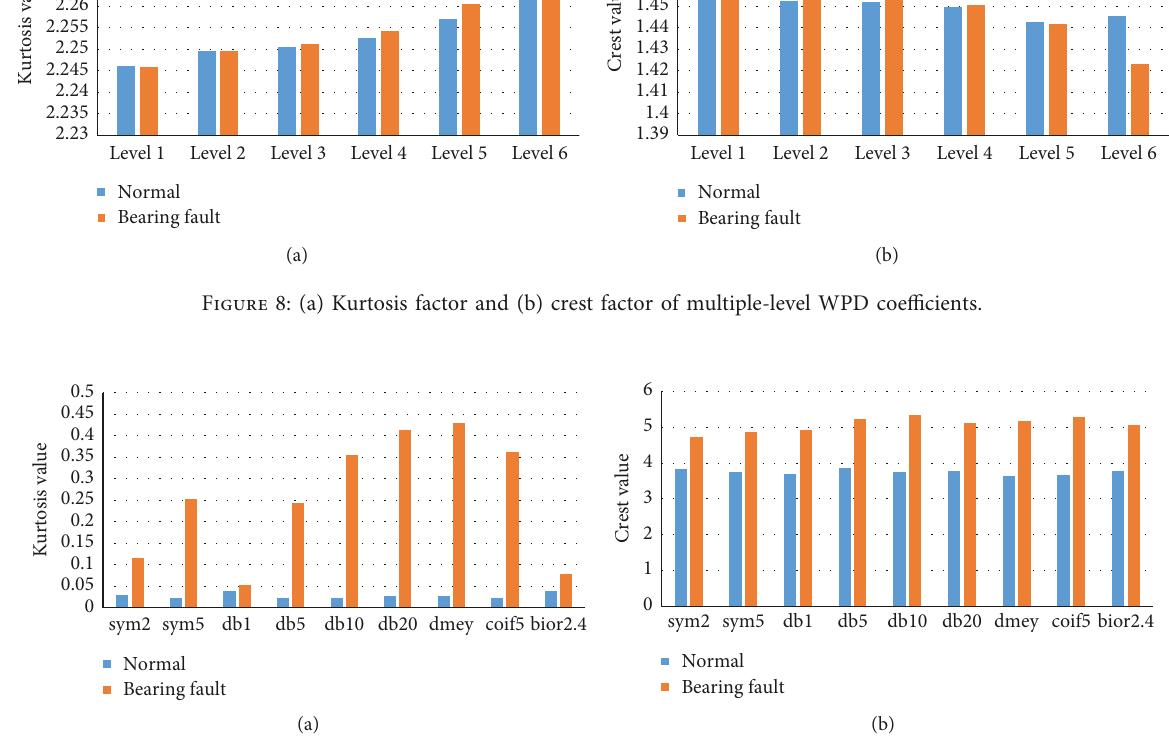
Figure 9: (a) Kurtosis factor and (b) crest factor of the current signal.